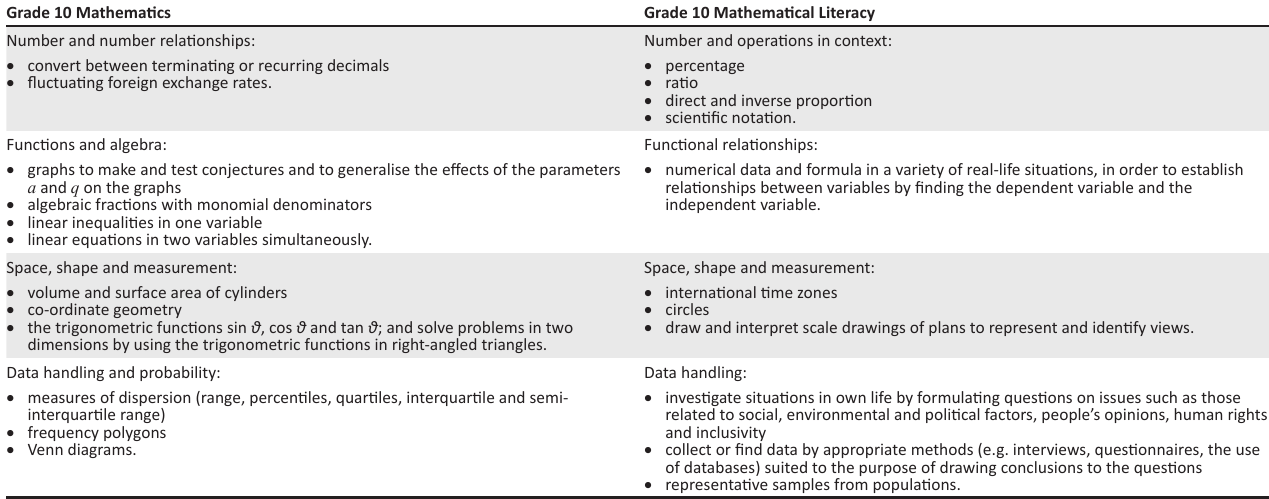
TABLE 2: Differences in content between Grade 10 Mathematics and Mathematical